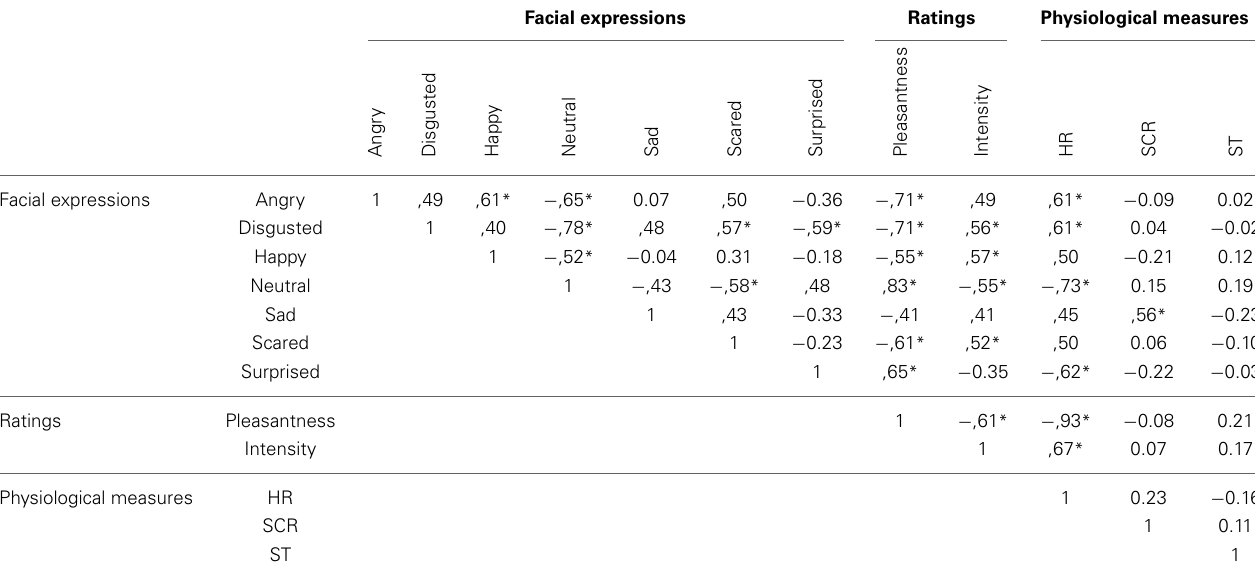
Table 2 | Pearson correlation coefficients between facial expressions, ratings and physiological measures for 24 stimuli averaged across participants. Facial expressions Ratings Physiological